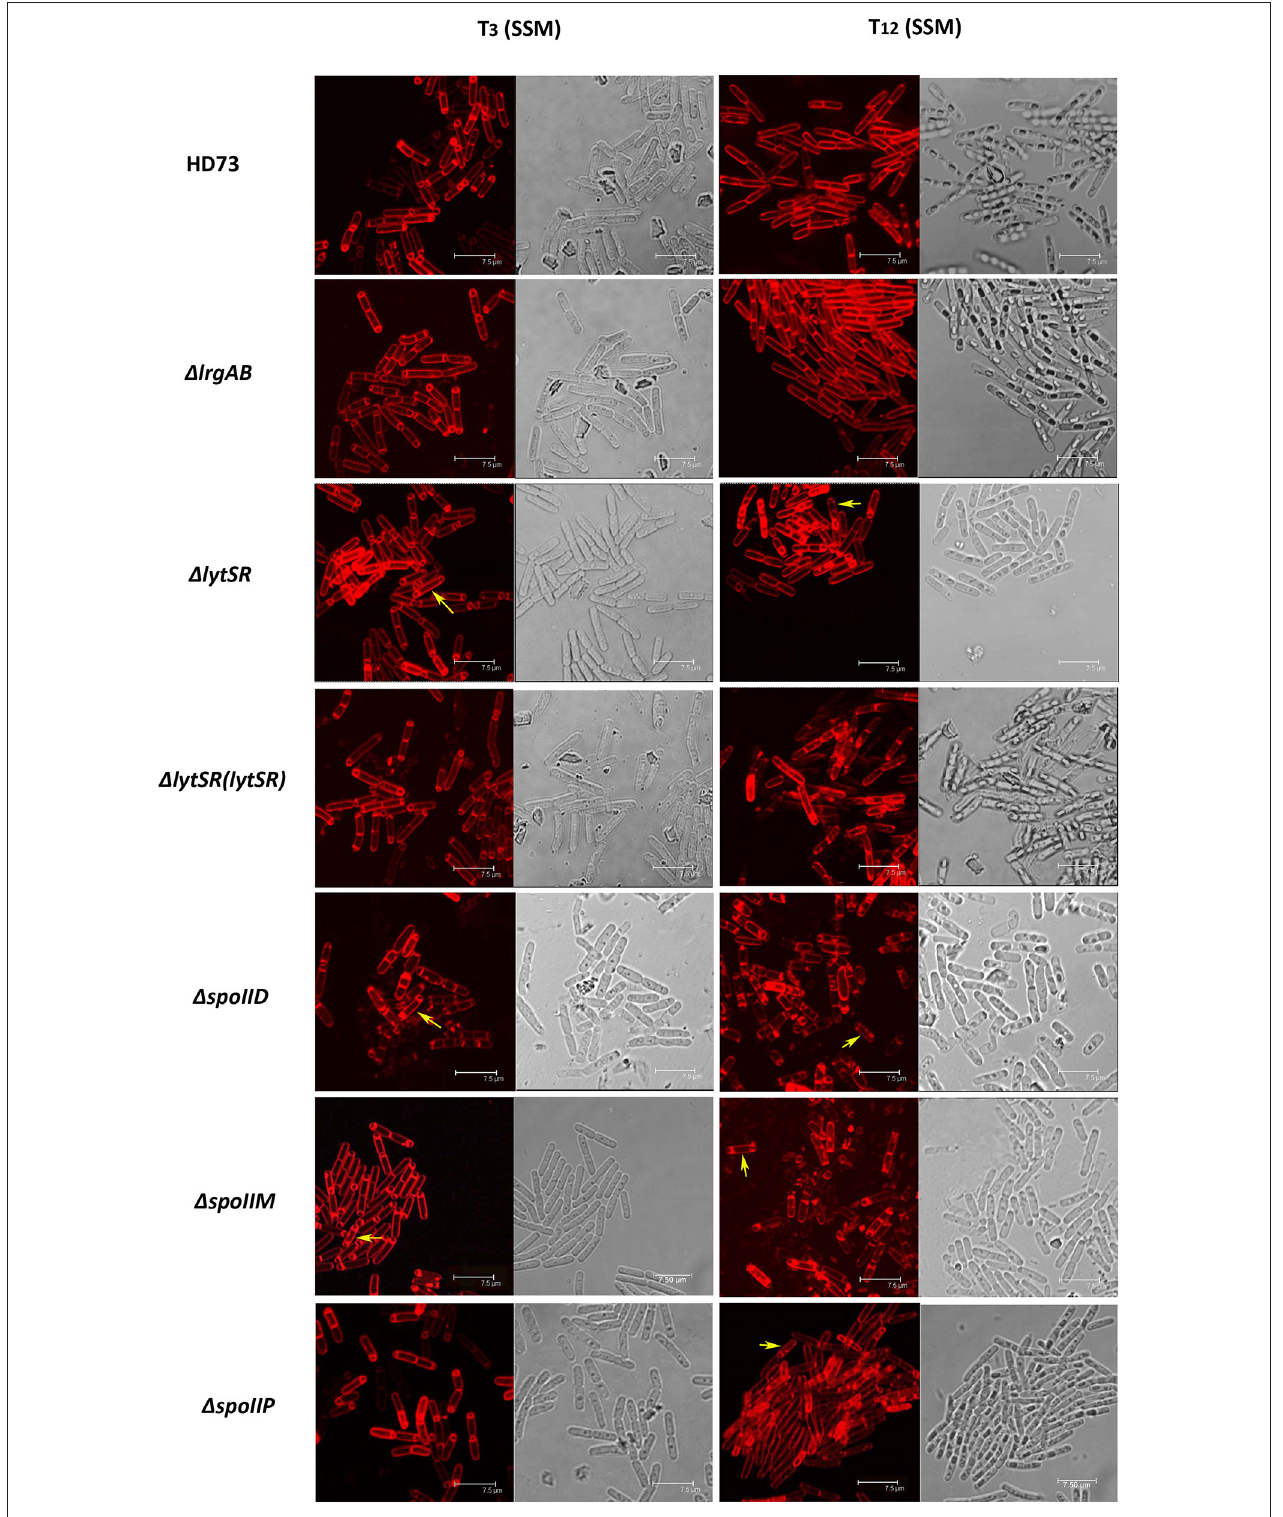
FIGURE 4 | Sporulation process in Bt HD73 in SSM. Laser scanning confocal micrographs of Bt wild-type HD73 cells and 1 lrgAB , 1 lytSR , 1 lytSR ( lytSR ), 1 spoIID , 1 spoIIM , and 1 spoIIP cells grown in SSM to T 3 and T 12 (30 ◦ C). Cell membrane is visible as red fluorescence. Yellow arrow indicates a bipolar septum. Bar, 7.5 µ m.